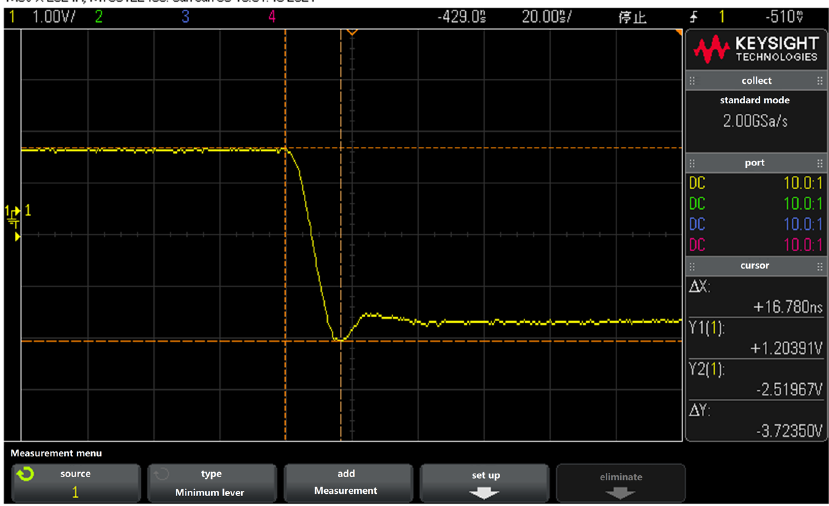
Figure 14. The reverse recovery waveform of 2CZ109C diode.